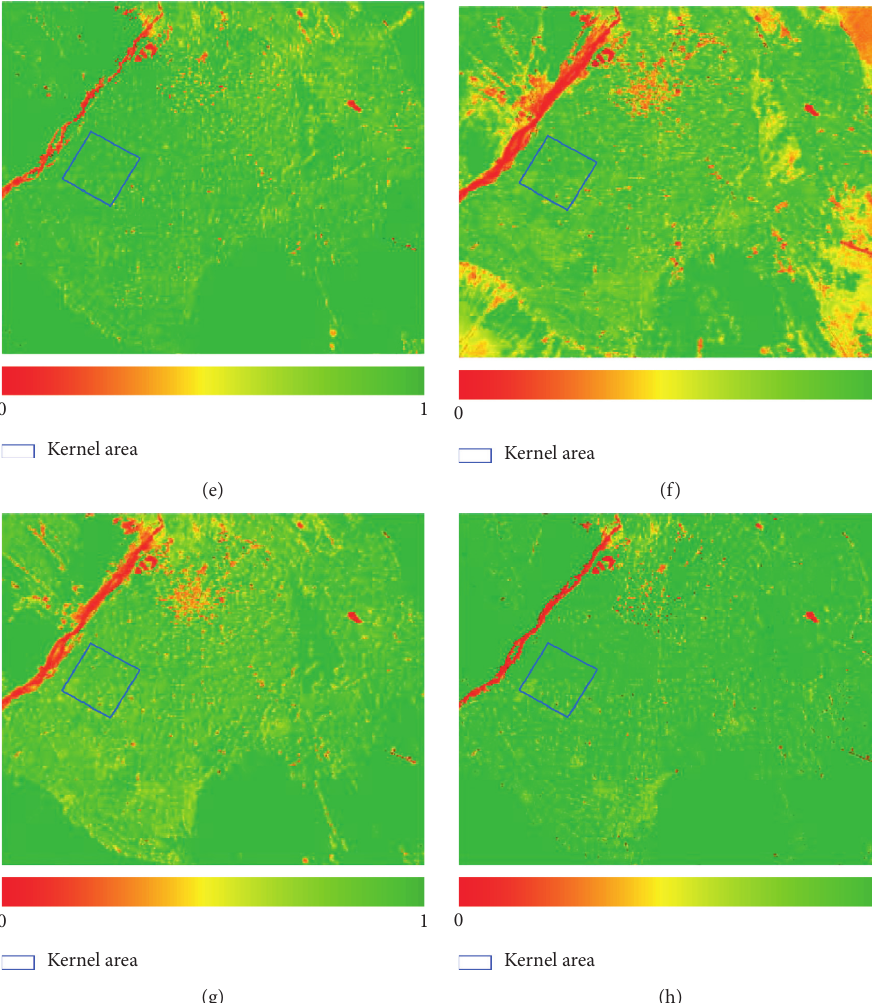
Figure 6: Spatial distribution of LE canopy /LE in eight dates ((a) 15 Jun; (b) 24 Jun; (c) 10 Jul; (d) 2 Aug; (e) 11 Aug; (f) 18 Aug; (g) 27 Aug; (h) 3